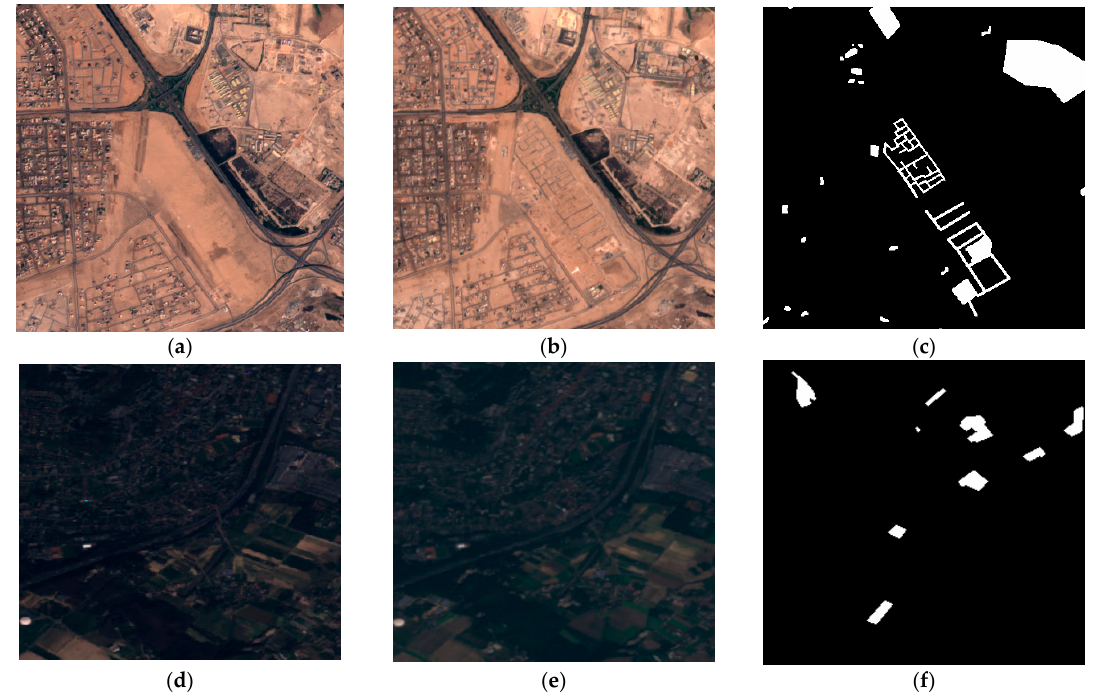
Figure 1. Multispectral datasets: ( a ) and ( b ) show the false-color composite of the multispectral images acquired over Abudhabi City, in United Arab Emirates (UAE) on January 20, 2016, and March 28, 2018, respectively, and ( c ) is the corresponding binary ground truth data which illustrates the change and no-change areas. ( d ) and ( e ) are the false-color composites of the multispectral images acquired over the Saclay area on March 15, 2016, and October 29, 2017, respectively, and ( f ) is the corresponding ground truth data, which white and black colors indicate the change and no-change areas, respectively.